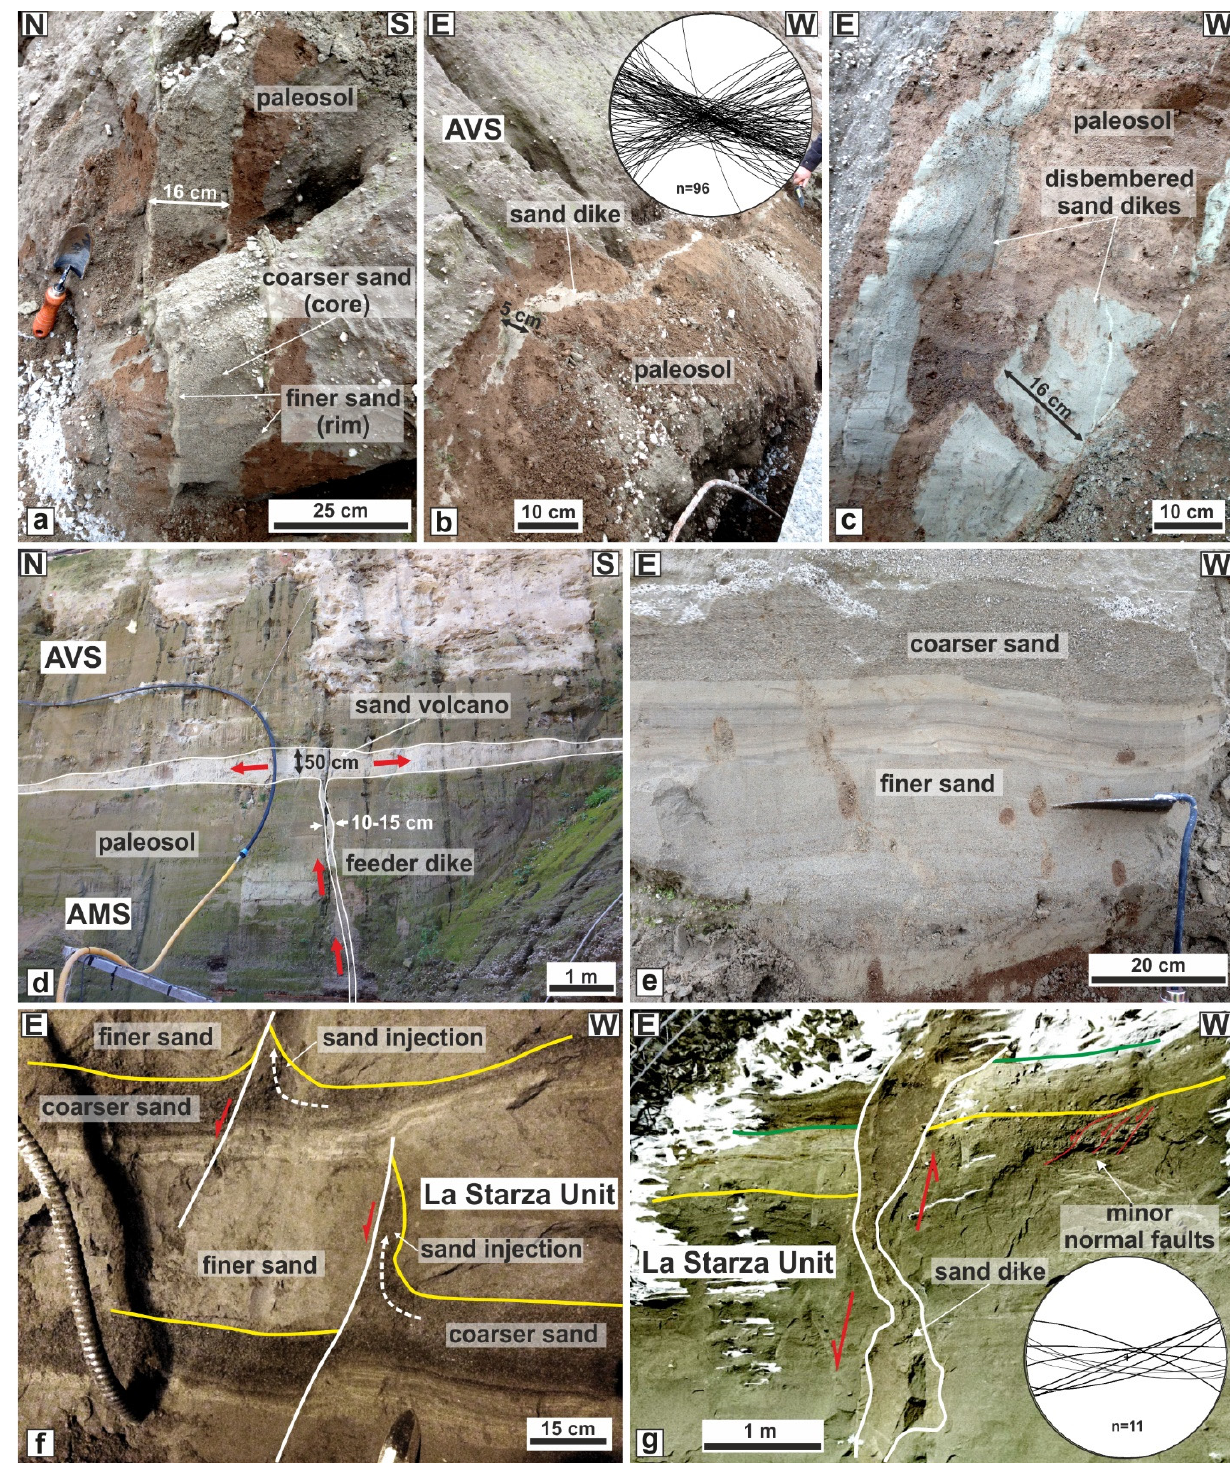
Figure 3. COPIN area (site 1). ( a , b ) Sand dike within the paleosol covering the AMS deposits and stereographic projection of dike boundaries. ( c ) Dismembered sand dike. ( d ) Sand volcano with feeding dike. ( e ) A section of the sand volcano flank. ( f ) Sand injections in the footwall of normal faults. ( g ) Hybrid normal fault with sand injection and stereographic projection of fault planes.